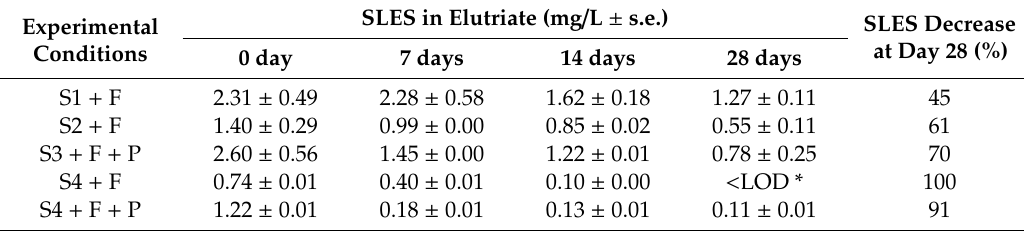
Table 6. SLES concentrations (mg / L) in elutriates obtained from the various conditioned microcosms (S1, S2, S3, S4) over 28 days (s.e. = standard